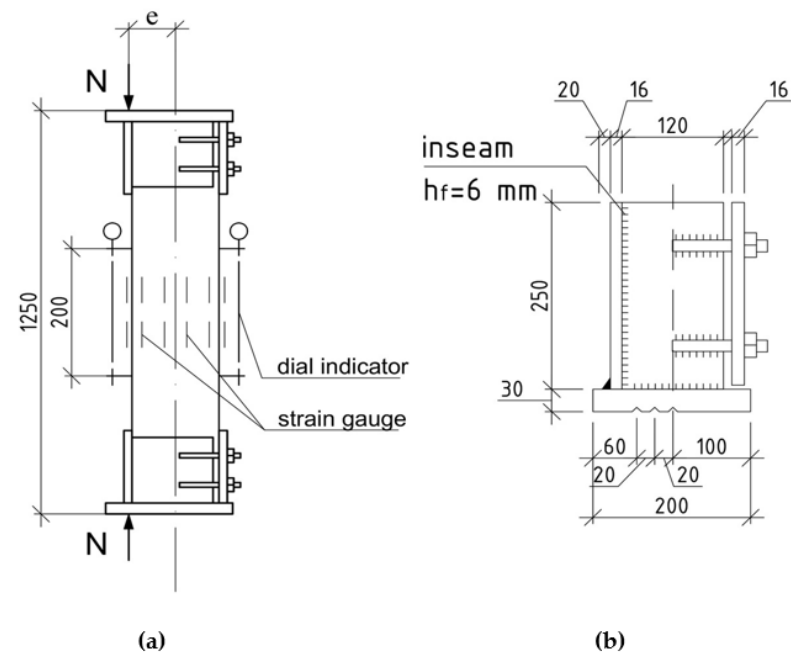
Figure 3. Head design: (a) is frontal view; (b) the device for eccentricity load.